Question: Based on the figure, does the quantity rise or fall?
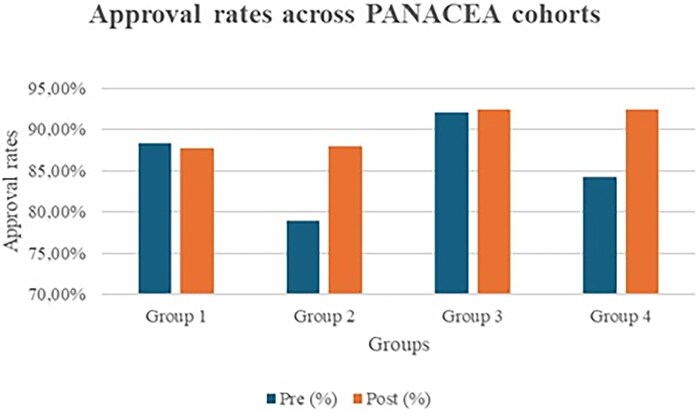
Answer: increasing